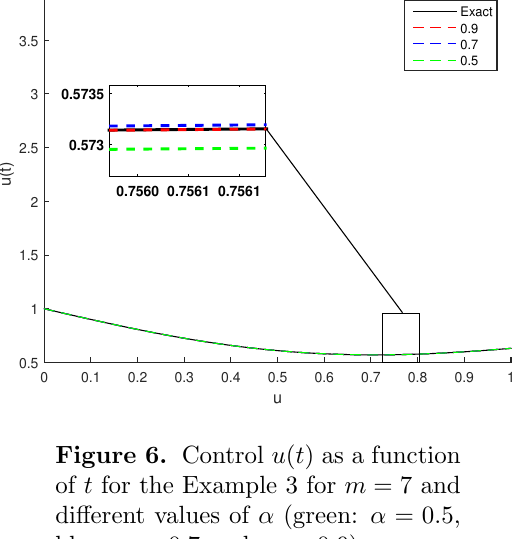
Figure 6. Control u ( t ) as a function of t for the Example 3 for m = 7 and different values of α (green: α = 0 . 5, blue: α = 0 . 7, red: α = 0 .